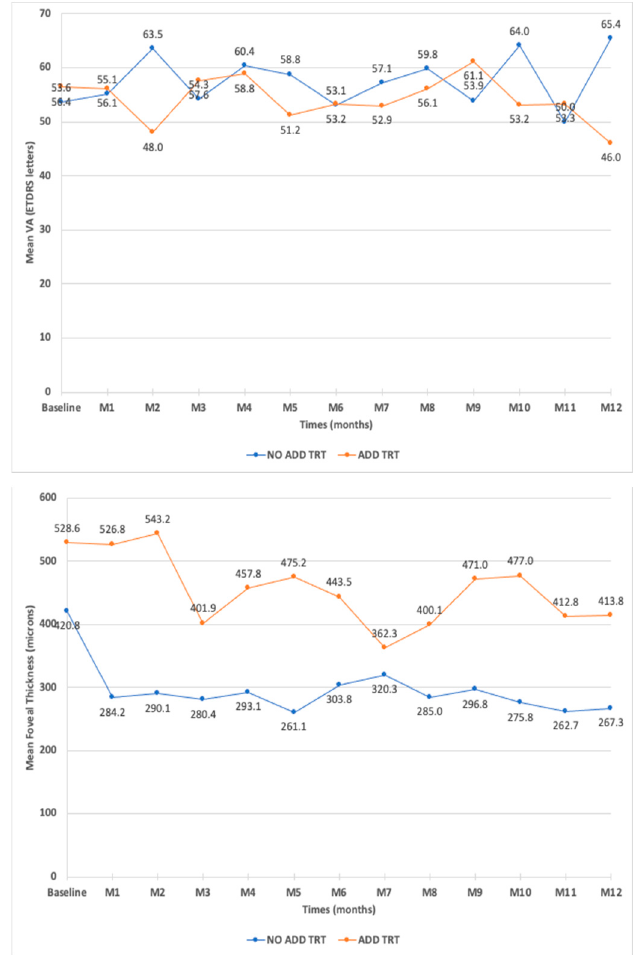
Figure 4. Mean best-corrected visual acuity (BCVA) and mean central retinal thickness (CMT) in eyes that needed additional treatments compared to eyes that did not need additional treatments after fluocinolone acetonide intravitreal injection.